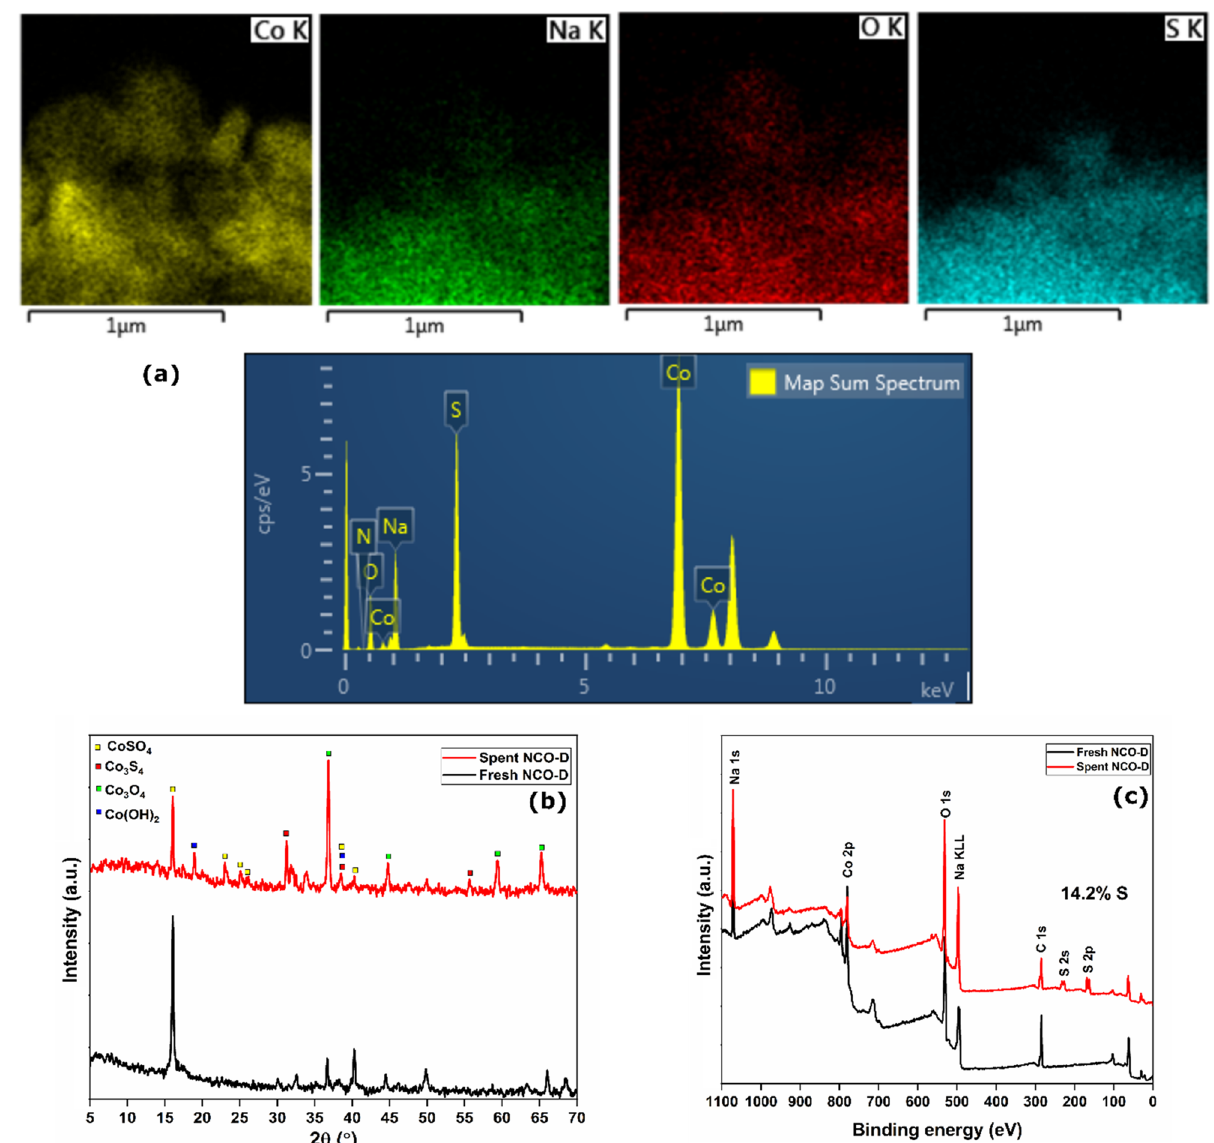
Figure 6. ( a ) TEM-EDS analysis; ( b ) PXRD patterns; ( c ) XPS surveys of spent NCO-D in dry